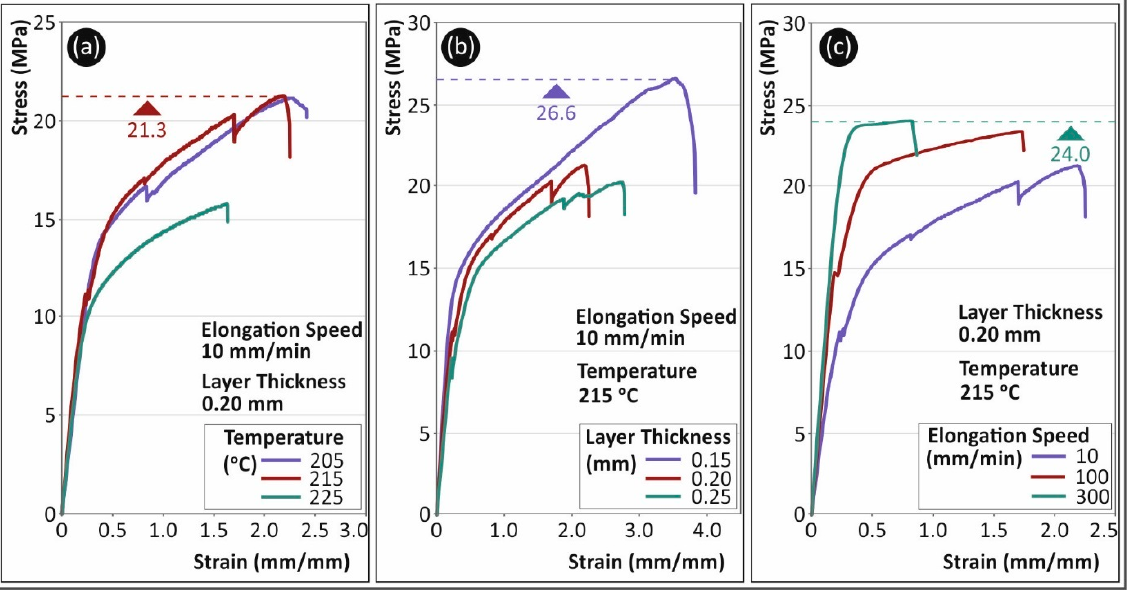
Figure 4. Stress (MPa) to strain (mm/mm) typical curves for TPU material for ( a ) different 3D printing temperatures, ( b ) different layer thicknesses and ( c ) different elongation speeds.